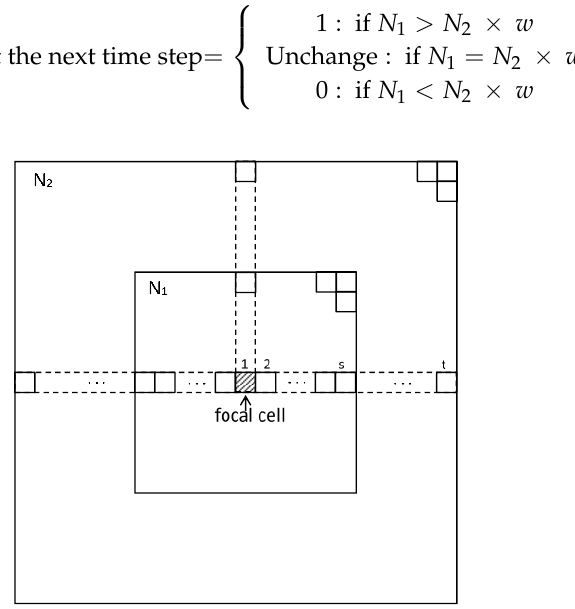
Figure 4. Schematic of the summing of states N 1 and N 2 . Each grid cell has state 0 (white) or 1 (black).